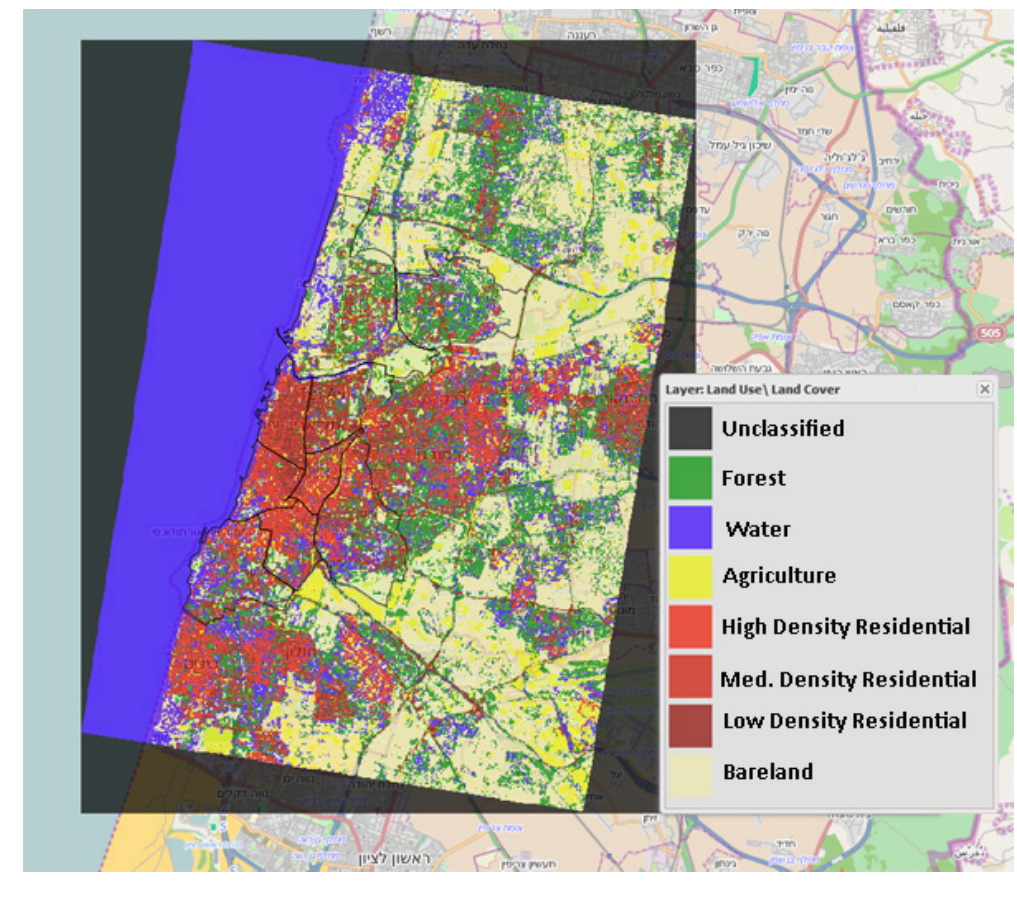
Figure 4. Land use map for Tel Aviv,